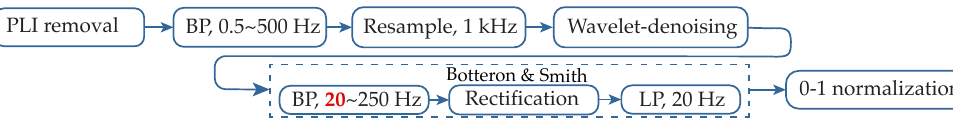
Figure 1. Block diagram of the preprocessing steps performed by the proposed algorithm. Botteron’s lowest cut-off frequency has been reduced to 20 Hz (red). PLI: powerline interference; BP: band-pass filter; LP: low-pass filter.